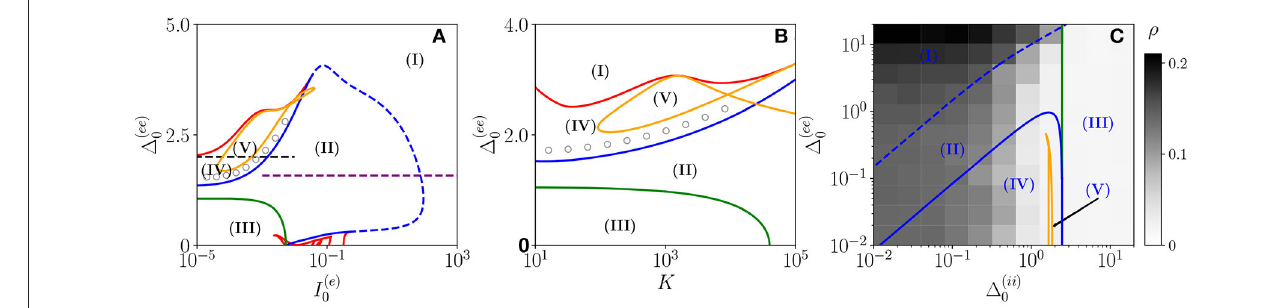
FIGURE 1 | Bifurcation diagrams of the neural mass model. The bifurcation diagrams concern the dynamical state exhibited by the excitatory population in the bidimensional parameter spaces ( I ( e ) 0 , 1 ( ee ) 0 ) (A) , ( K , 1 ( ee ) 0 ) (B) , and ( 1 ( ii ) 0 , 1 ( ee ) 0 ) (C) . The regions marked by Roman numbers correspond to the following collective solutions: (I) an unstable focus; (II) a stable focus coexisting with an unstable limit cycle (LC); (III) a stable node; (IV) an unstable focus coexisting with a stable LC; (V) a chaotic dynamics. The green solid line separates the regions with a stable node (III) and a stable focus (II). The blue solid (dashed) curve is a line of super-critical (sub-critical) Hopf bifurcations (HBs), and the red one of saddle-node (SN) bifurcations of LCs. The yellow curve denotes the period doubling (PD) bifurcation lines. In (C) , we also report the coherence indicator ρ ( e ) (Equation 4) estimated from the network dynamics with N ( e ) 10,000 and N ( i ) = 2,500. The dashed lines in (A) indicate = the parameter cuts we will consider in Figures 4 , 5 (black) and Figure 7 (purple), while the open circles in (A,B) denote the set of parameters employed in Figure 11 . I ( e ) 0 / 1.02, g ( ee ) 0 0.96286; other 0.3, g ( ei ) 0 0.953939, g ( ie ) 0 0.27, g ( ii ) 0 In the three panels, the inhibitory DC current and the synaptic couplings are fixed to I ( i ) 0 = = = = = parameters: (A) K 1,000, 1 ( ii ) 0 0.3, (B) I ( e ) 0 0.001, 1 ( ii ) 0 0.3, (C) K 1,000, and I ( e ) 0 = = = = = =